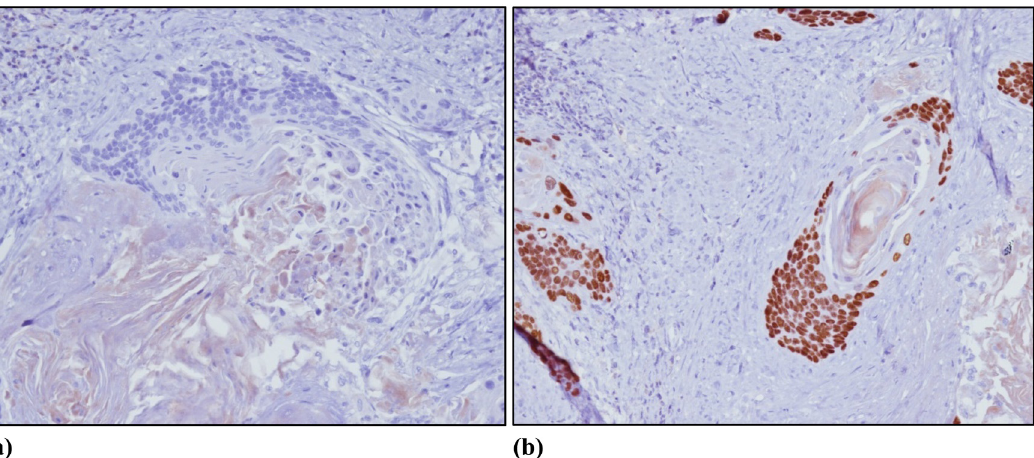
Figure 4: Immunohistochemical features. ( a ) Negative nuclear expression of GATA - 3 in tumor cells. ( b ) Positive expression of p63 in tumor